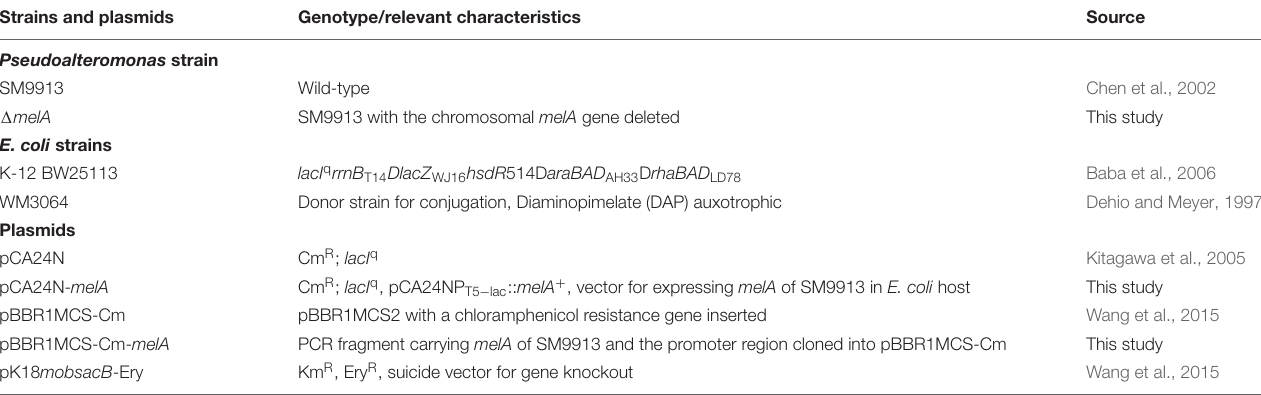
TABLE 1 | The bacterial strains and plasmids used in this